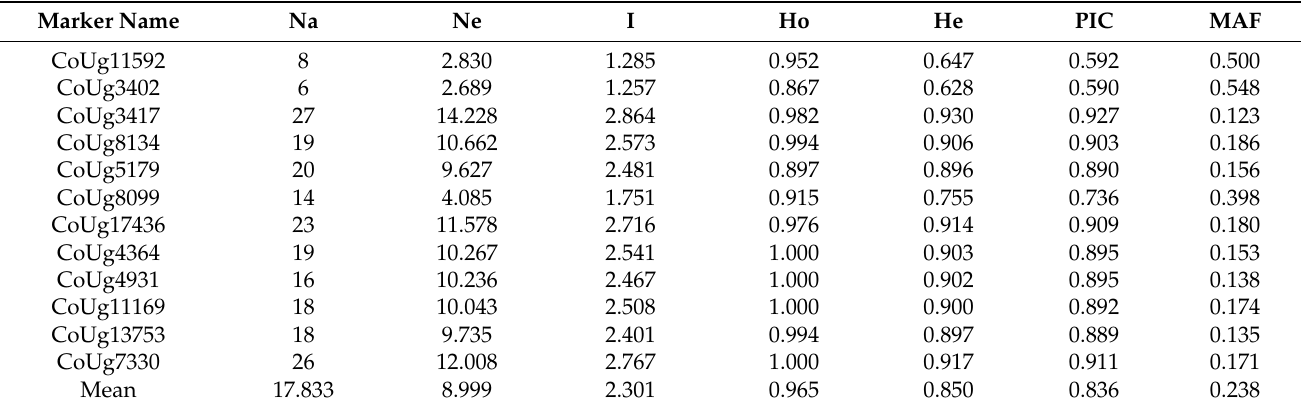
Table 5. Genetic parameters based on 12 SSR in this study.